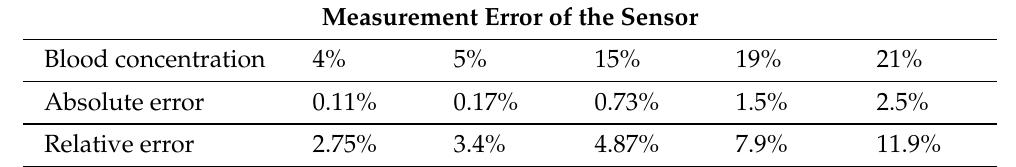
Figure 10. ( Left ): full system setup for clinical laboratory trials using blood from human donors: (1) blood donor, (2) display, (3) 3D bladder model, (4) Hb sensor, (5) urine bag, and (6) pump. The sensor was used in an extended setup, which is not in the scope of this paper. ( Right ): two exemplary measurement curves for increasing and decreasing Hb concentrations. Sensor time constants were estimated as 33 s for rise and 119 s for fall. Table 2. Measurement errors with respect to the measured blood concentration. With increasing blood concentration the measurement accuracy drops due to the non-linearity of Beer’s Law. We note that these values were acquired during development and were not part of the clinical